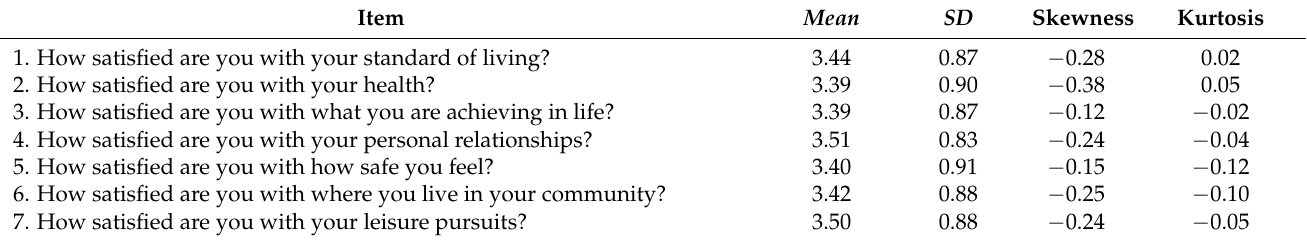
Table A13. Descriptive analysis of wellbeing satisfaction ( n = 1200, two samples combined).